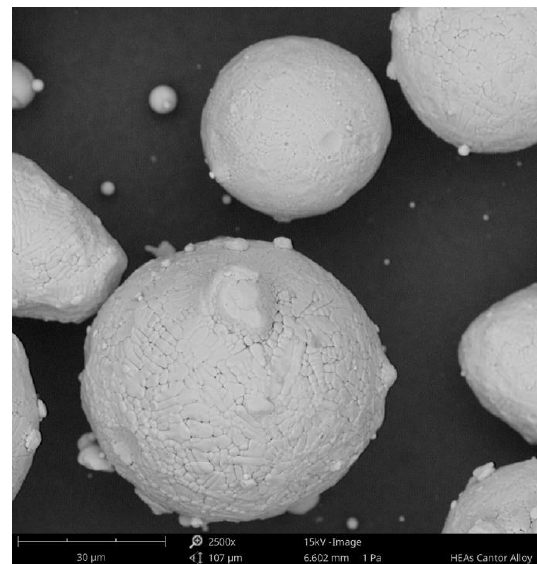
Figure 2. High-entropy alloy powders.